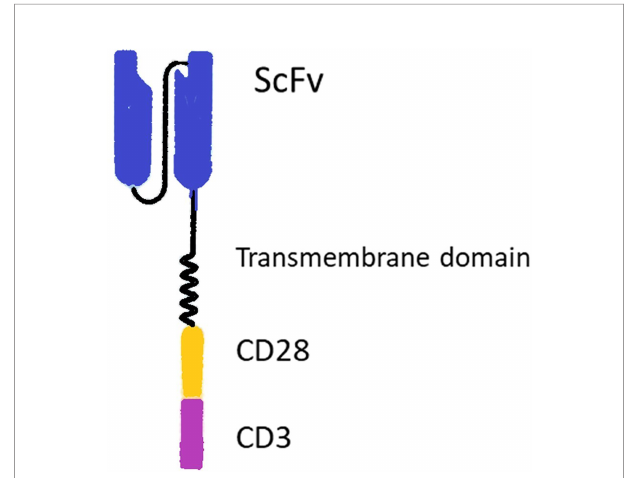
FIGURE 1 | Structure of a chimeric antigen receptor (CAR). The CAR includes extracellular binding moiety (ScFv), a transmembrane domain, and intracellular signaling domains (i.e., usually CD3 z chain of T cell receptor and CD28 co-stimulatory